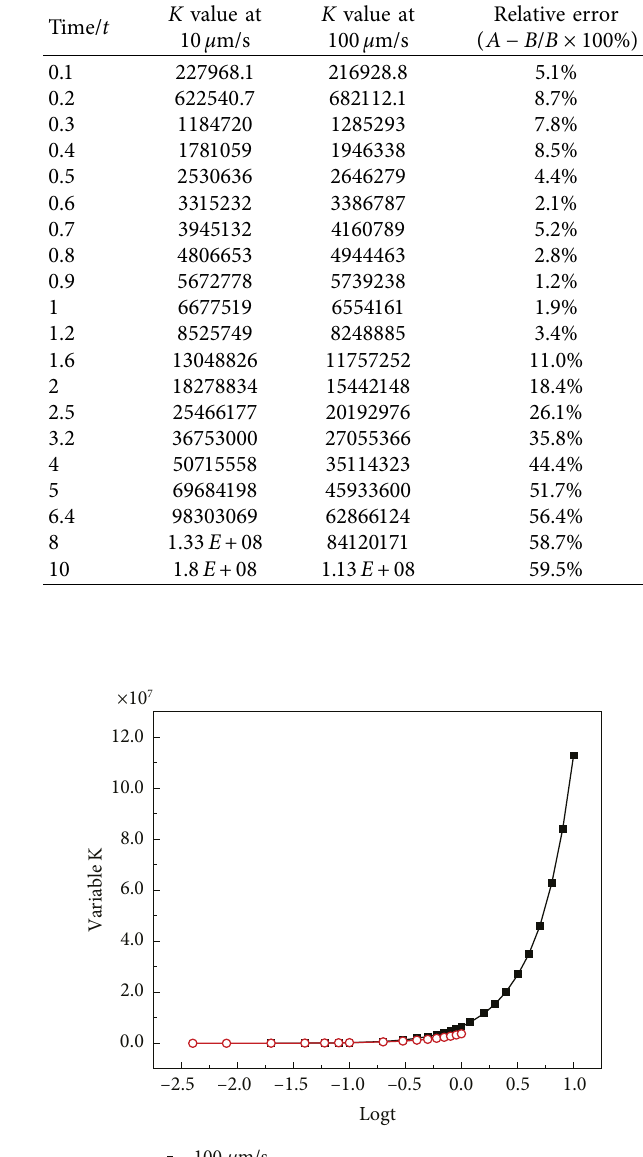
Figure 5: 10 μ m / s data and 100 μ m / s data comparison.